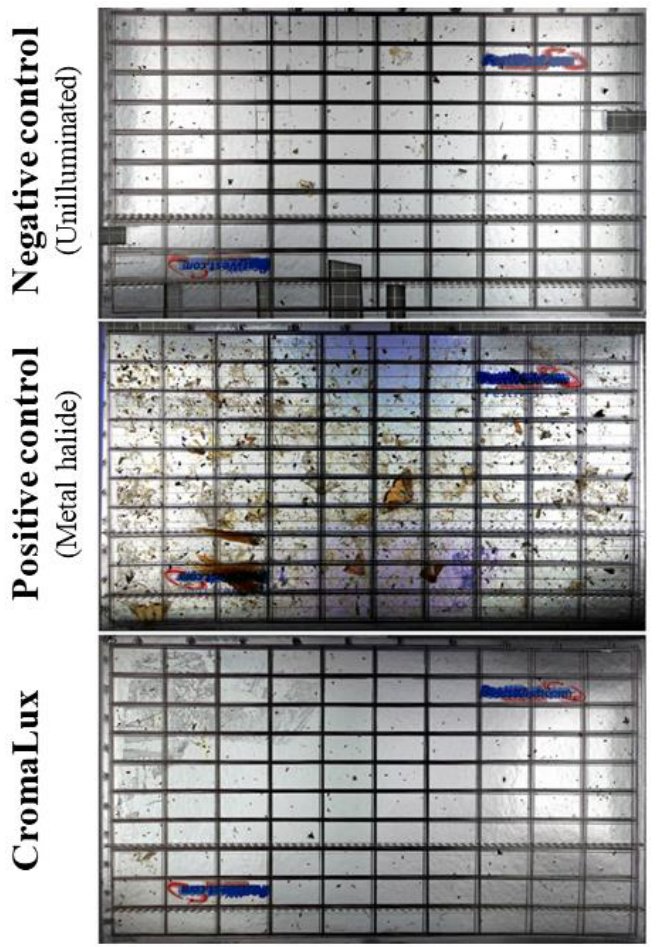
Figure 5. Overlapped photographs of all sticky board traps for the three lighting